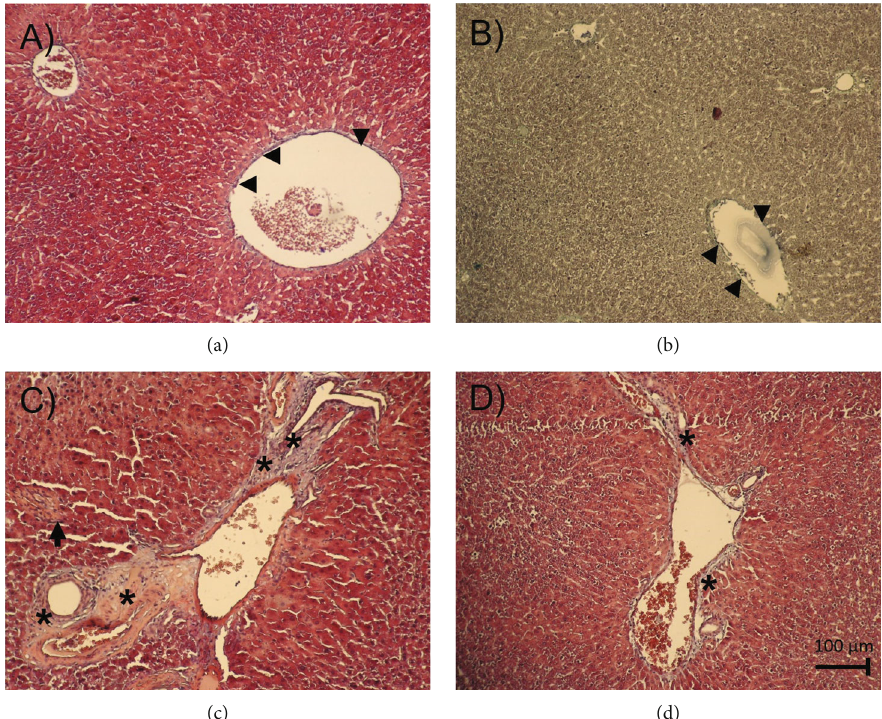
Figure 8: Liver slides stained with Masson ’ s trichrome to identify collagen distribution (blue) in the several experimental groups. In (a) from an IC and (b) from a NIL group, a thin pattern of collagen fi bers is distributed around the triad (hepatic artery, bile duct, and portal vein) (arrowhead). (c) PCA liver slide. An increase in collagen distribution around the vessels of the triad and a mild invasion into the liver parenchyma is observed ( ∗ ). In addition, isolated foci of in fl ammation are observed (arrow). (d) PCA+NIL liver slide. In comparison with the PCA group, the collagen distribution around the triad and liver parenchyma is less apparent ( ∗ ). All photographs are taken at 20x magni fi